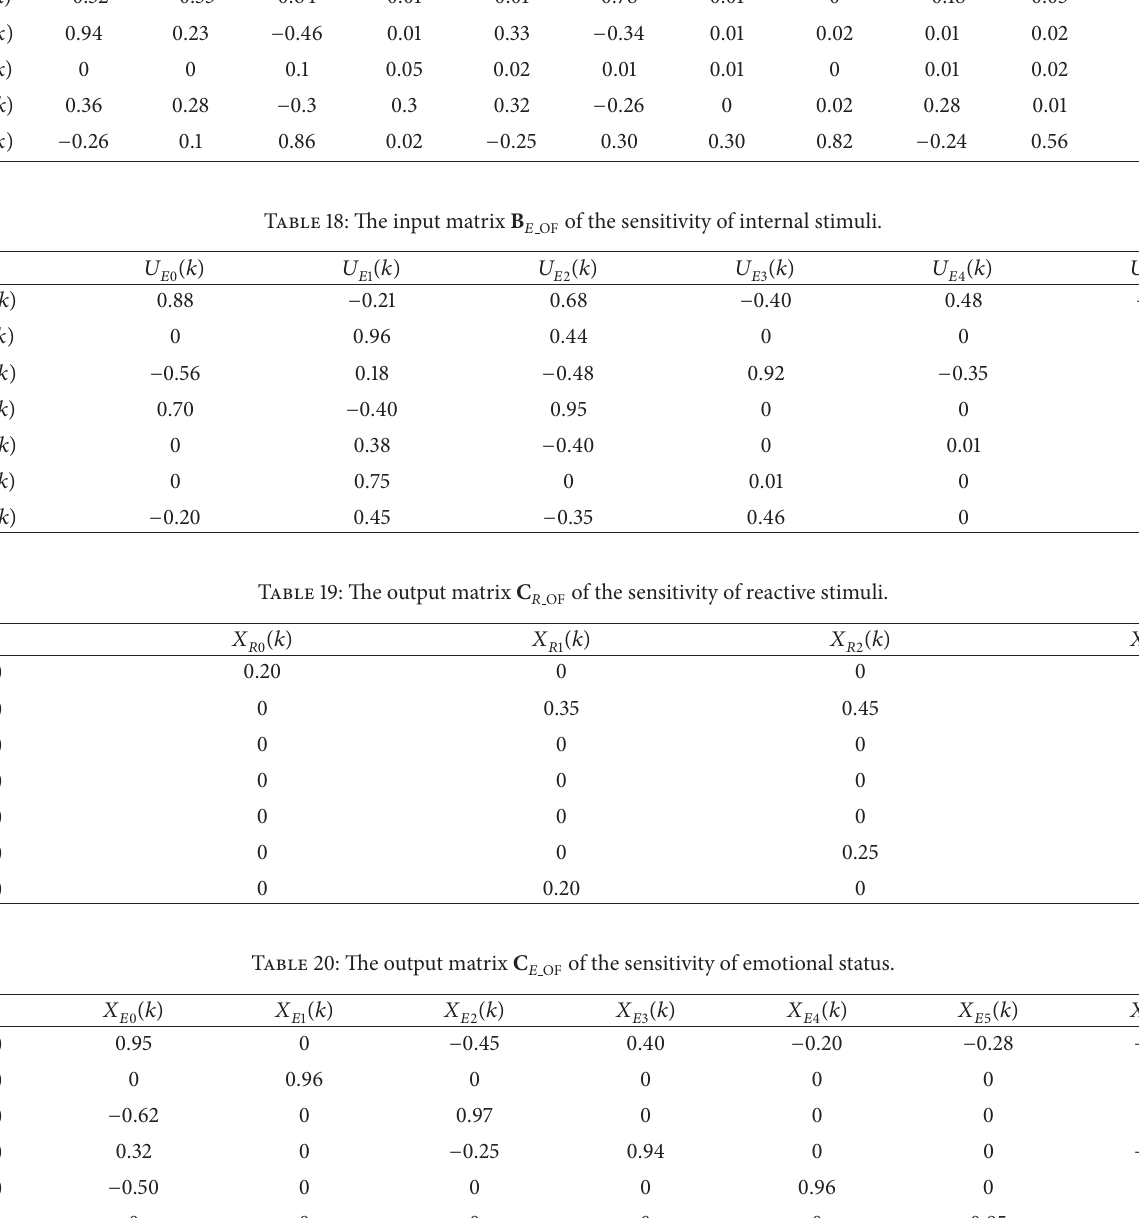
Table 17: The input matrix B 𝐼